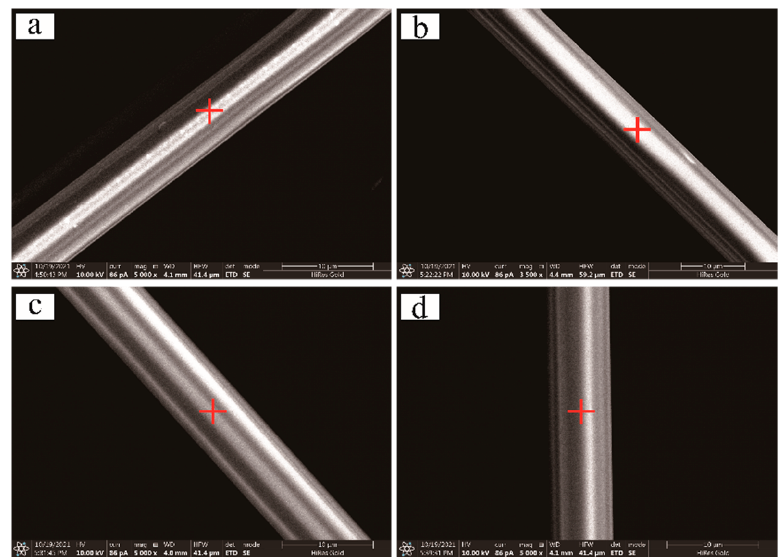
Figure 8. SEM images of the surface of sample fiber ‐ 1 before and after the gamma irradiation (before ( a ) gamma irradiation; ( b ) 50 kGy; ( c ) 100 kGy; ( d ) 150 kGy; Table 2. EDX analysis results of sample fiber ‐ 1.